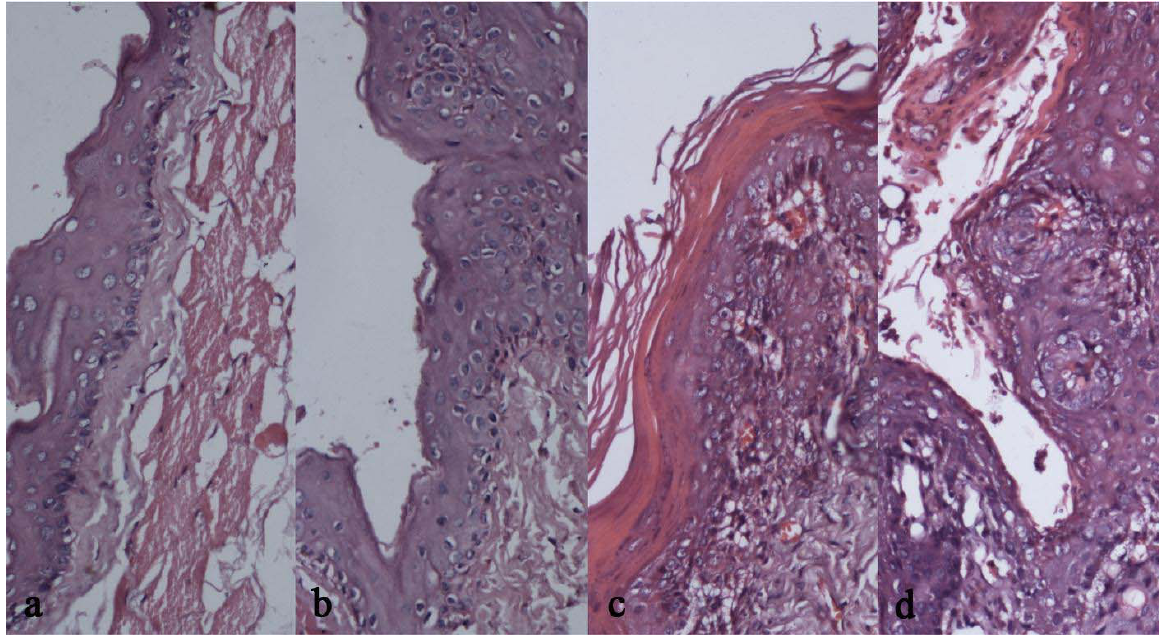
Figure 3. ( a ). Tissue sections at 9 weeks in the Treatment Group; ( b ). Tissue sections at 9 weeks in the Model Group; ( c ). Tissue sections at 12 weeks in the Treatment Group; ( d ). Tissue sections at 12 weeks in the Model Group.